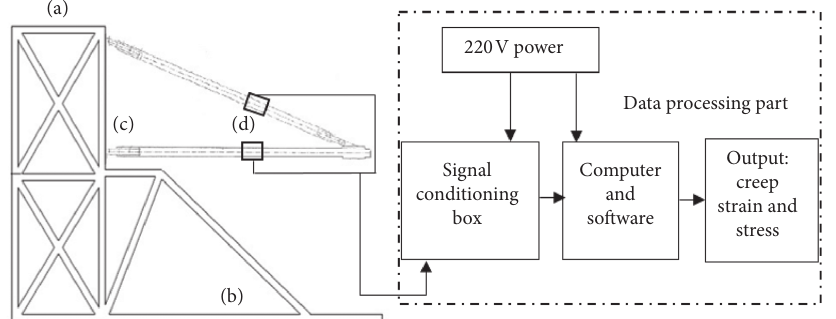
Figure 3: Concept of the test setup.